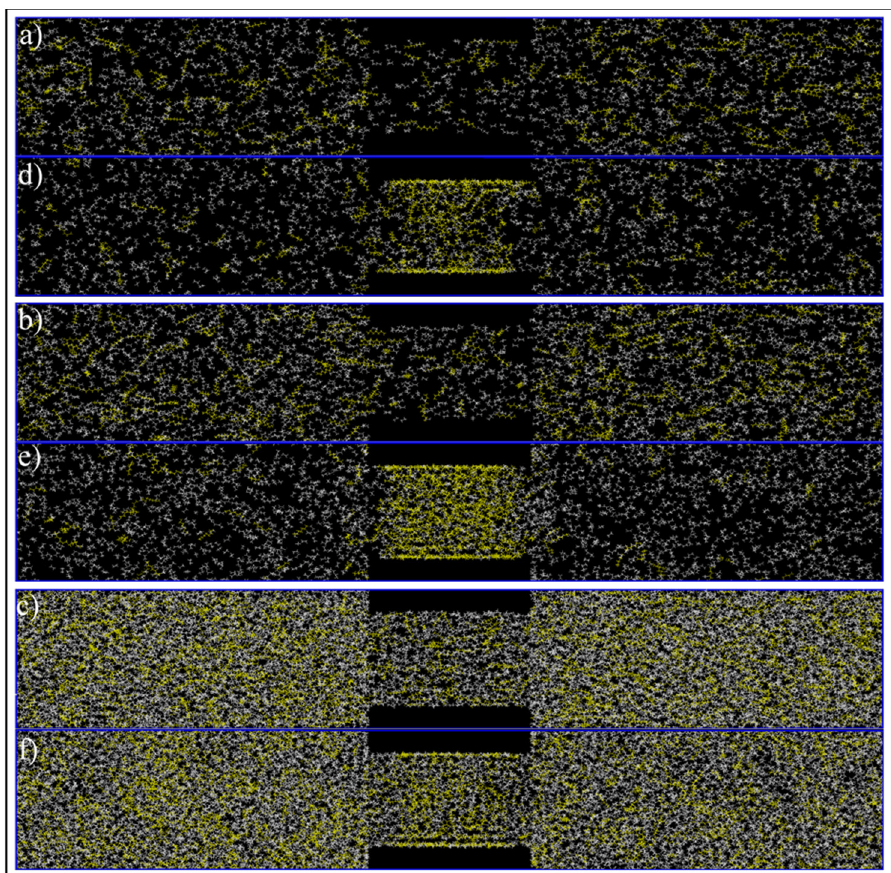
Figure 13. Initial ( a – c ) and final configuration ( c – e ) of ethane–heptane mixture at C1 ( a , d ), C2 ( b , e ) and C3 ( c , f ) conditions. Yellow and white colors represent heptane and ethane molecules, respectively. Table 1. Initial and final heptane mass fraction in bulk and inside the nanopore-confined space.